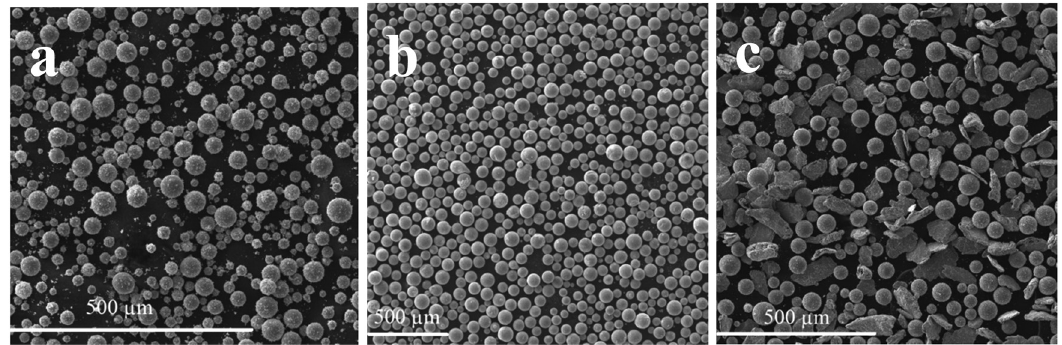
Figure 6: Morphology of the powder in the modes 1, 7, and 8; feed rate height of 0 ( a ) , + 10 ( b ) , and − 10 ( c ) .